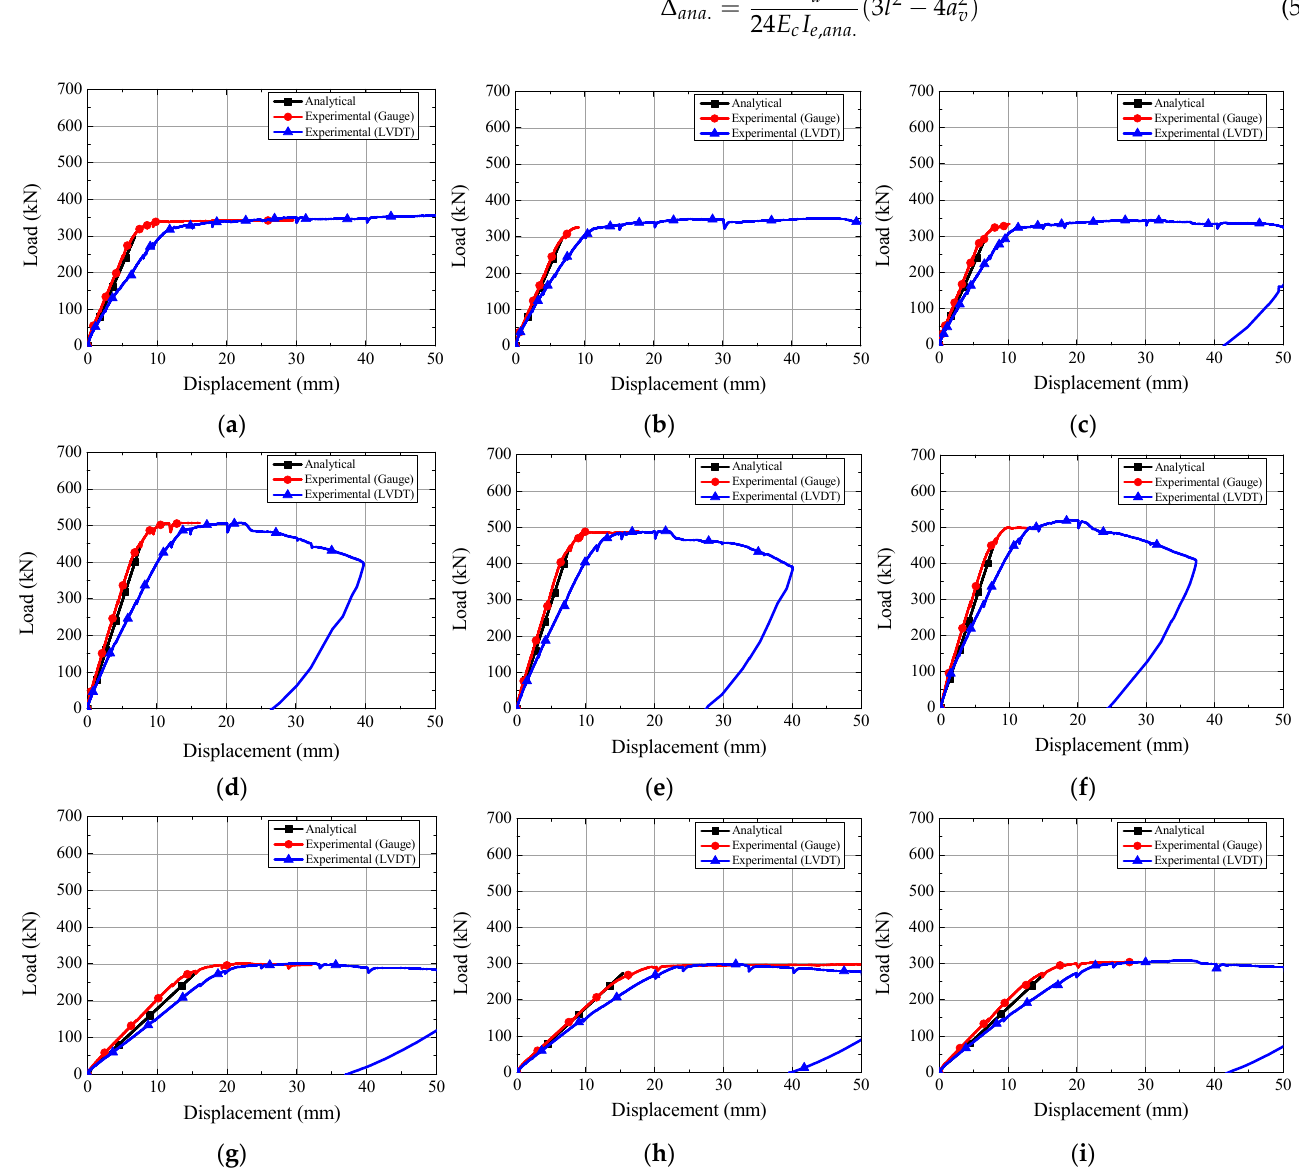
Figure 7. Comparison of experimental and analytical results: ( a ) B3-2.5a; ( b ) B3-2.5b; ( c ) B3-2.5c; ( d ) B6-2.5a; ( e ) B6-2.5b; ( f ) B6-2.5c; ( g ) B6-4.0a; ( h ) B6-4.0b; ( i ) B6-4.0c.